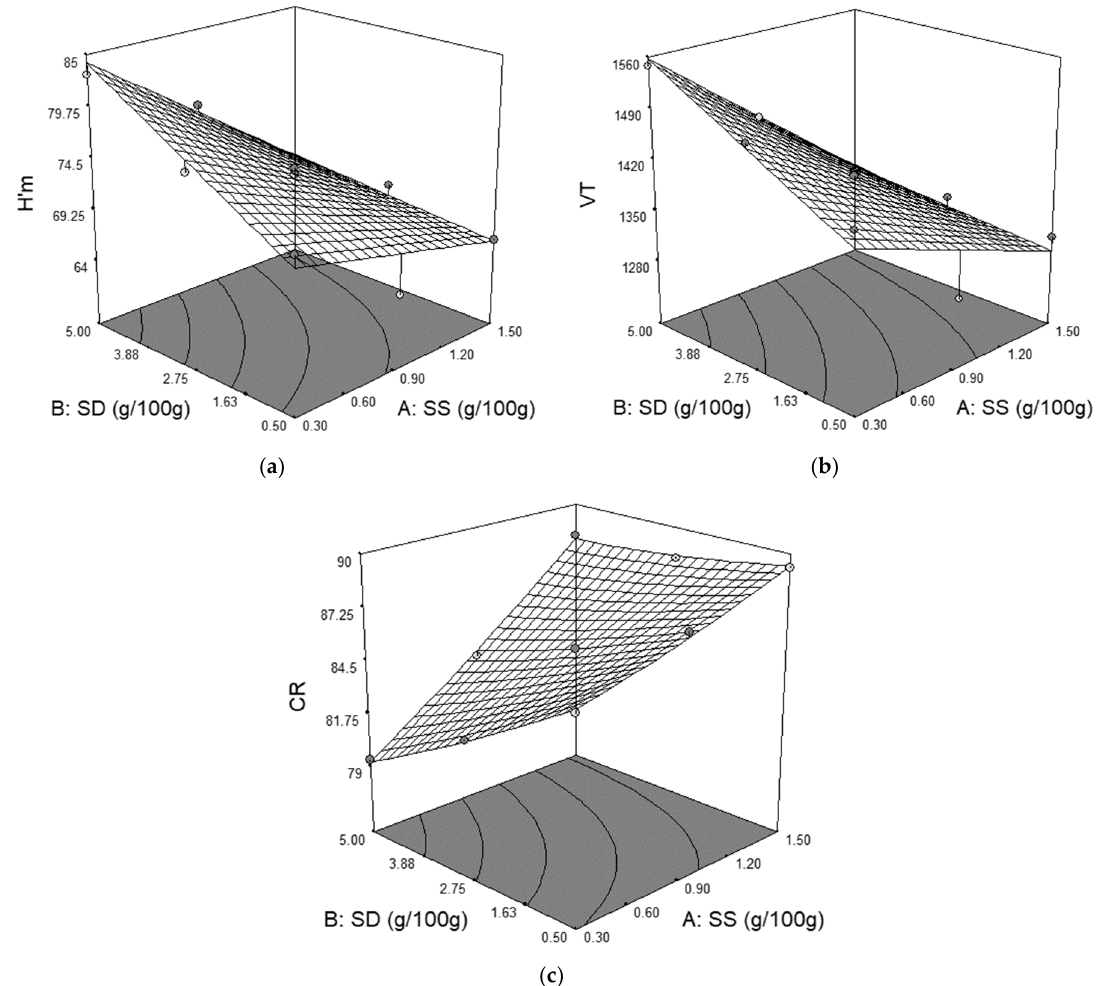
Figure 3. The graphical representations of the Rheofermentometer parameters: ( a ) maximum height of gaseous production (H’ m ); ( b ) total CO 2 volume production (VT); and ( c ) retention coe ffi cient (CR).